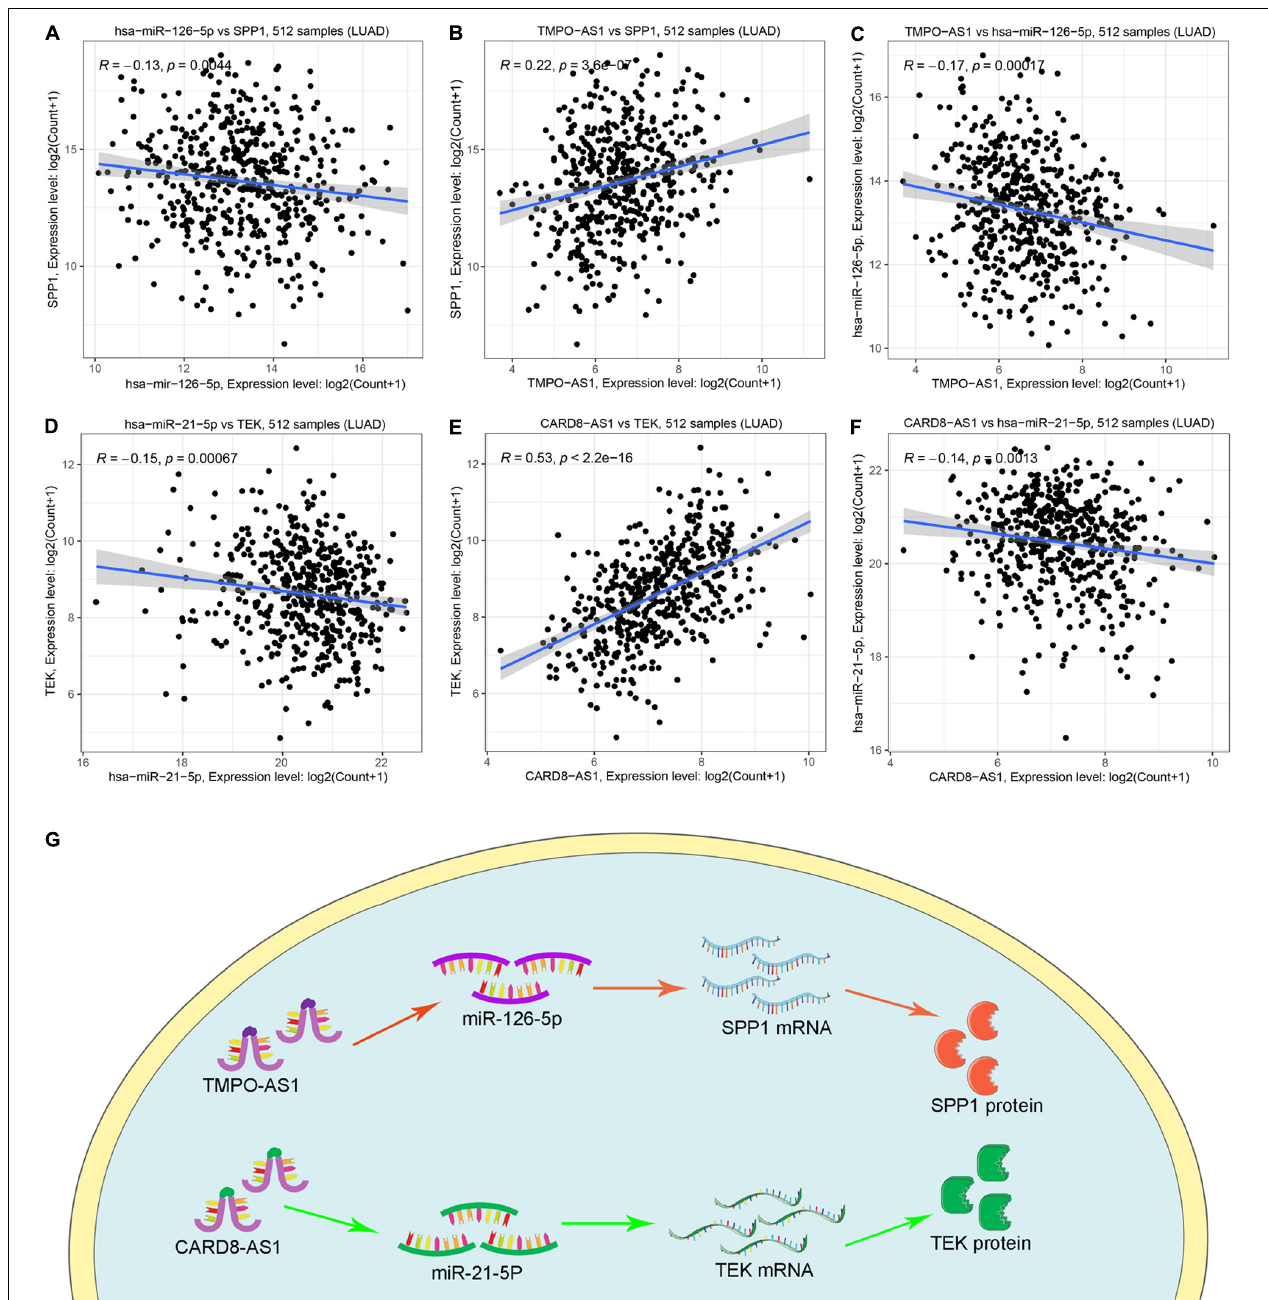
FIGURE 7 | The co-expression analysis of ceRNA network and schematic representations. (A–C) The coexpression analysis indicated miR-126-5P was negatively correlated with SPP1 and TMPO-AS1, whereas TMPO-AS1 was positively correlated with SPP1. (D–F) The coexpression analysis indicated miR-21-5P was negatively correlated with TEK and CARD8-AS1, whereas CARD8-AS1 was positively correlated with TEK. (G) Schematic representations of TMPO-AS1/miR-126-5p/SPP1 and CARD8-AS1/miR-21-5p/TEK as immune-related ceRNA networks in LUAD progression.